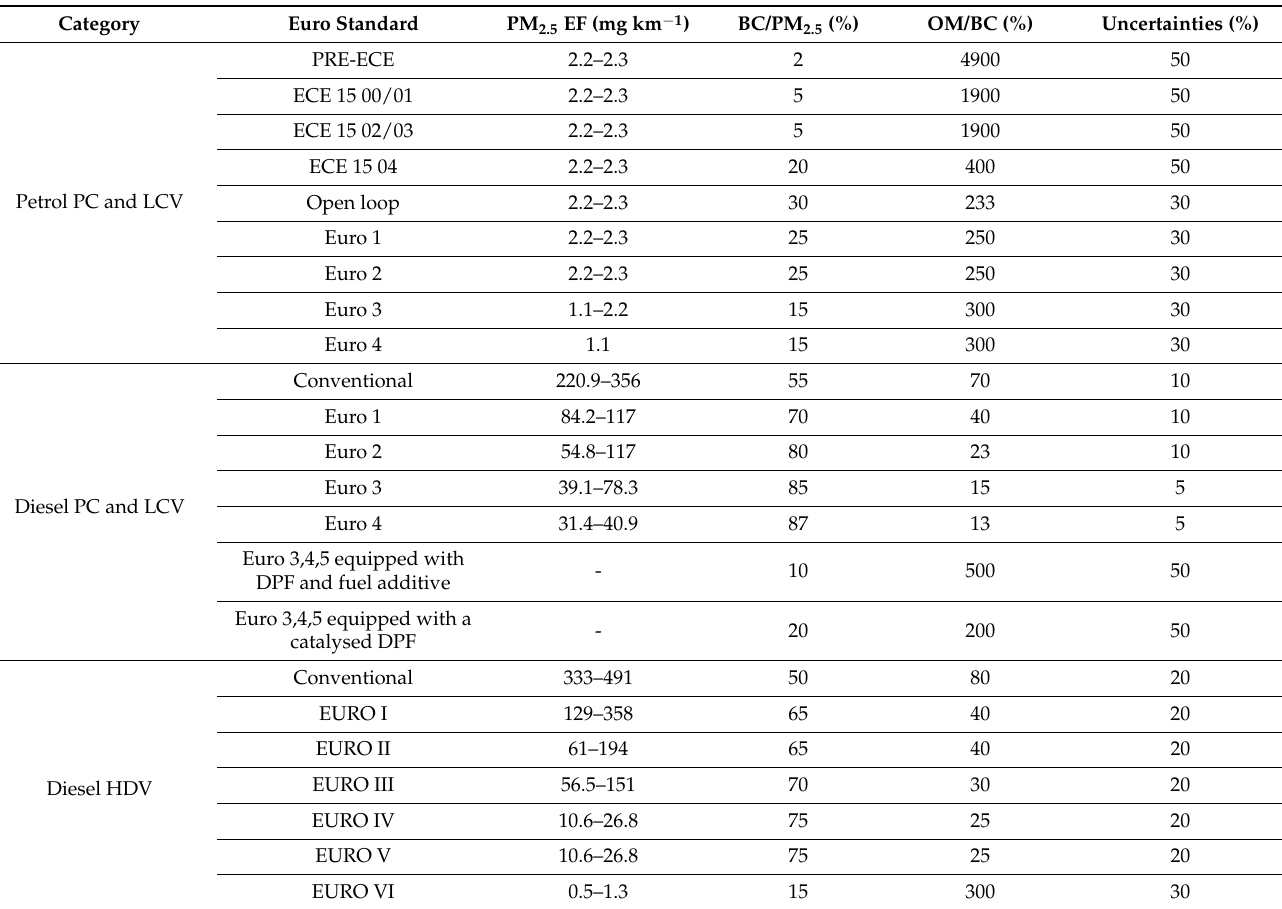
Table 5. PM 2.5 emission factors, split of PM in elemental (BC) and organic mass (OM) from Ntzi- achristos and Samarras